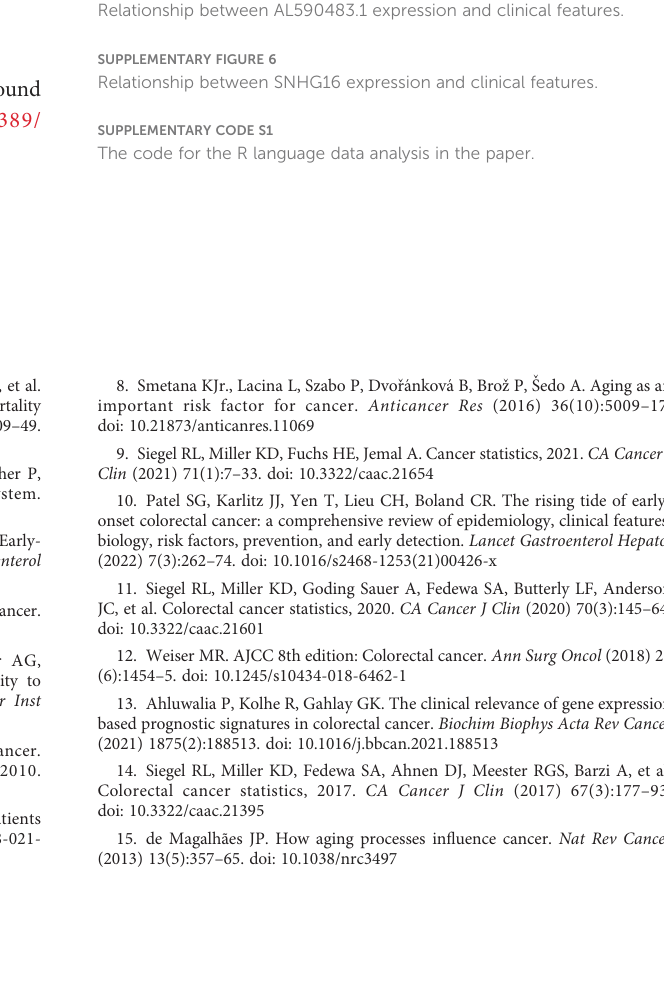
SUPPLEMENTARY TABLE 5 AC107375.1 is involved in the regulation of 59 genes. SUPPLEMENTARY TABLE 6 The IC50 and AUC of the drugs on CRC cell lines. SUPPLEMENTARY FIGURE 1 Relationship between ZEB1-AS1 expression and clinical features. SUPPLEMENTARY FIGURE 2 Relationship between AC068580.3 expression and clinical features. SUPPLEMENTARY FIGURE 3 Relationship between AC107375.1 expression and clinical features. SUPPLEMENTARY FIGURE 4 Relationship between AC147067.1 expression and clinical features. SUPPLEMENTARY FIGURE 5 Relationship between AL590483.1 expression and clinical features. SUPPLEMENTARY FIGURE 6 Relationship between SNHG16 expression and clinical features. SUPPLEMENTARY CODE S1 The code for the R language data analysis in the